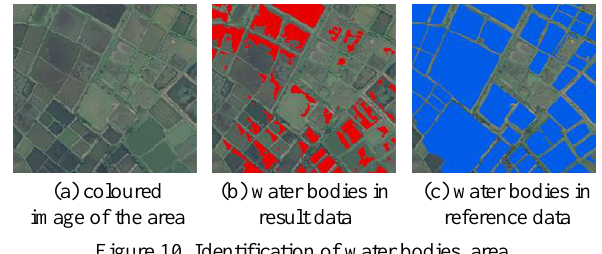
Figure 10. Identification of water bodies area (© coloured image by ESRI)